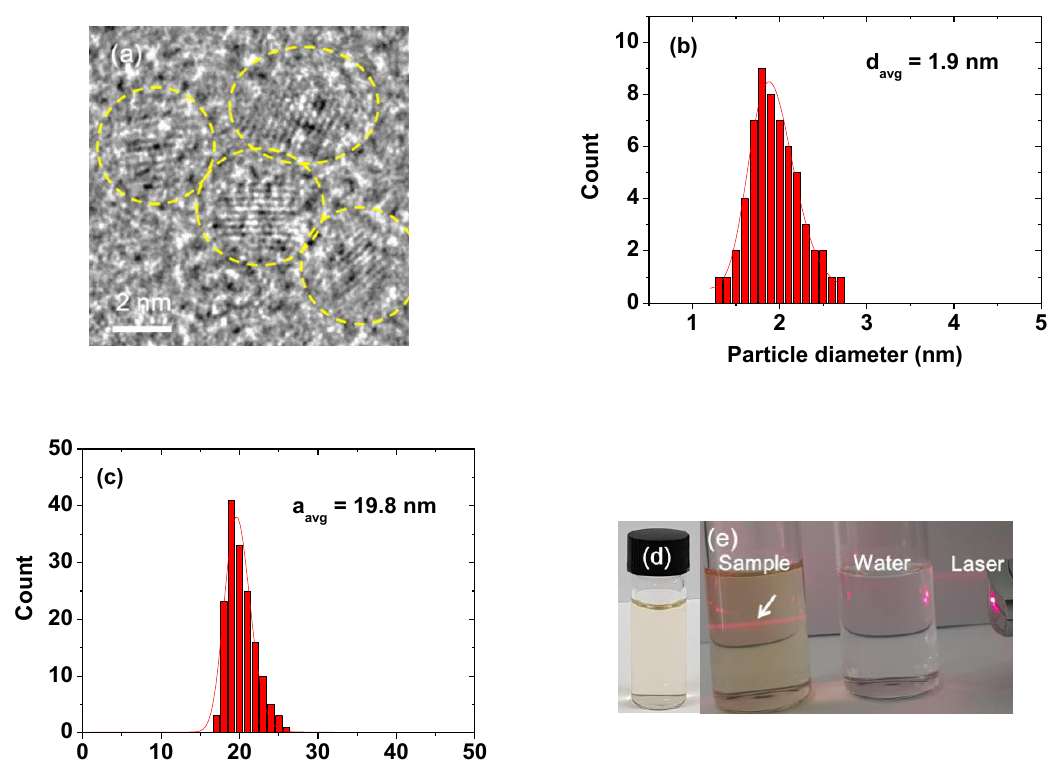
Figure 1. ( a ) HRTEM image (dotted circles indicate PMVEMA-coated ultra-small Gd 2 O 3 NPs). ( b ) Log-normal function fit to the observed particle diameter distribution. ( c ) Log-normal function fit to the observed hydrodynamic diameter distribution. ( d ) Photograph of an aqueous solution sample, showing good colloidal stability. ( e ) Tyndall e ff ect, indicating a colloidal dispersion: the left vial containing the solution sample showed laser light scattering by the PMVEMA-coated NP colloids (indicated with an arrow), whereas the right vial containing triple-distilled water did not. Table 1. Summary of the properties of PMVEMA-coated ultra-small Gd 2 O 3 NPs. d avg